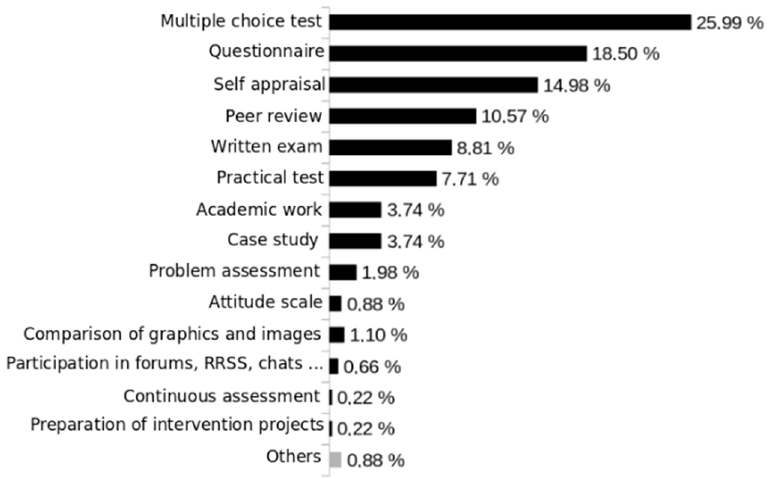
Figure 4. Mode of evaluation in MOOC experiences.